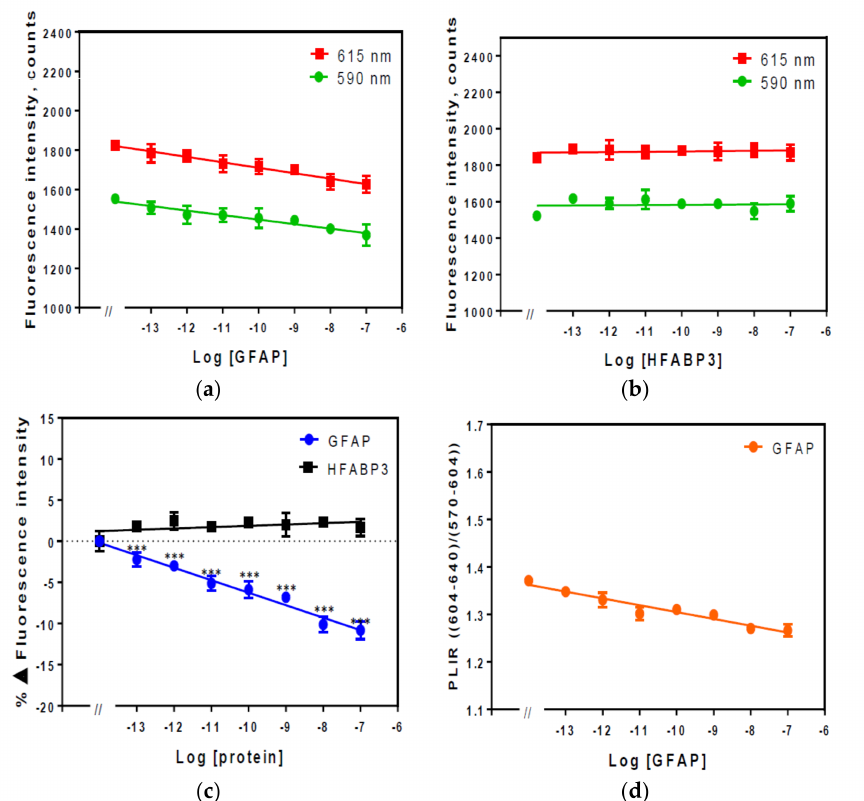
Figure 4. Fluorescence intensity spectra of Eu 3+ chelated by PMDA modified anti-GFAP Affimer complex in 1% ( v / v ) serum. Fluorescence was measured at 590 and 615 nm with λ ex = 395 nm. ( a ) Fluorescence intensity spectra of Eu 3+ chelated PMDA modified anti-GFAP Affimer; ( b ) fluorescence intensity spectra of the same complex after HFABP3 added; ( c ), percentage change in fluorescence intensity; ( d ) photoluminescence intensity ratio. Data are means ± SEM ( n = 4). Some error bars are smaller than data points (*, ** and *** indicate significance with p -value < 0.05, 0.01, and 0.001 respectively of the specific analyte (GFAP) compared to the control (HFAPB3) data).